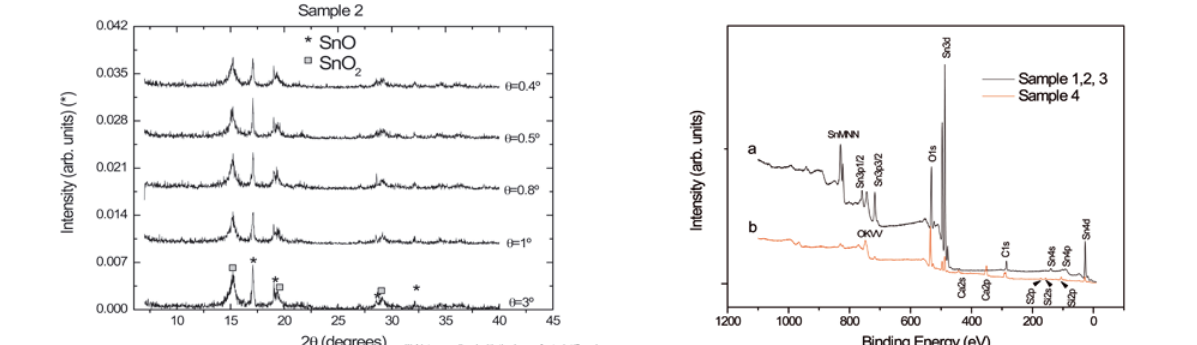
Figure 7. XRD profiles at different incidence angle φ = 0.4º to 3º of Sample 4